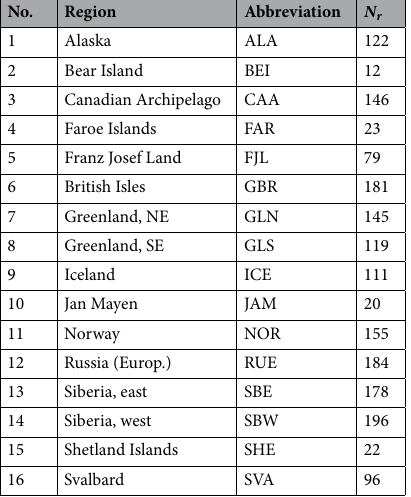
Table 1. Coastal regions used in the study with their abbreviated names and number of particle release locations N r